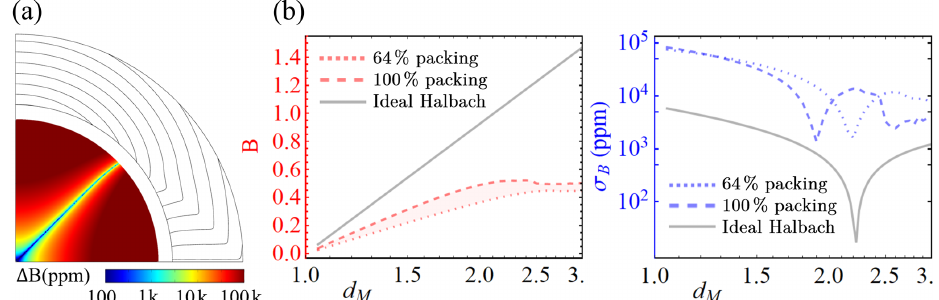
Figure 3. Panel (a) shows the implementation of the structures in Fig. 2, in their self-aligned, minimum-energy condition, from powdered material. (b) Dependence of field intensity and homogeneity, inside the inner half-radius, on an increasing magnet size, as defined by the outer radius normalised by the anchor’s radius, d M